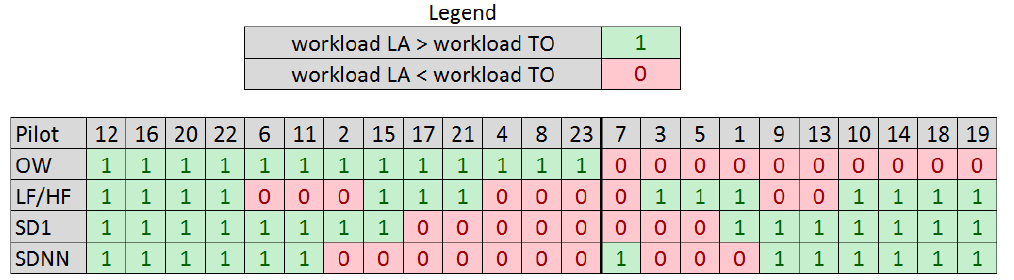
Figure 12. NASA-TLX and HRV